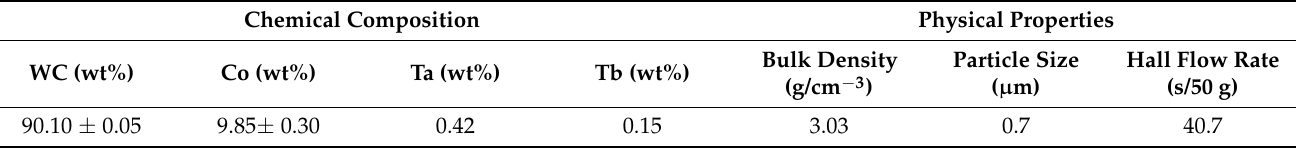
Table 1. Main chemical composition of the mixed